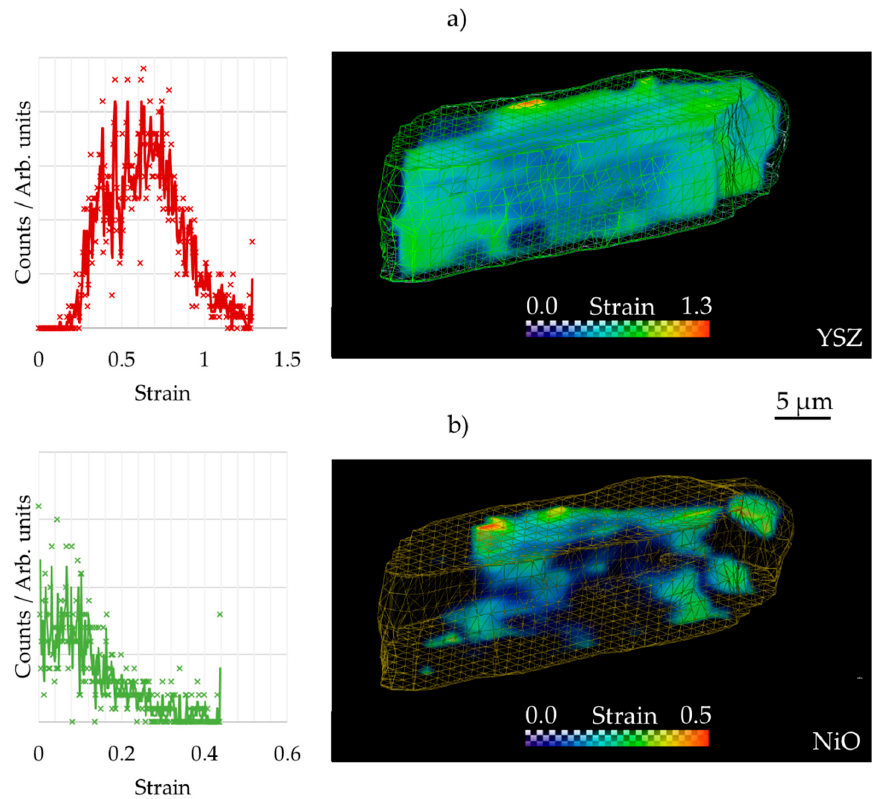
Figure 5. Crystallographic strain mapped in 3D using synchrotron XRD-CT. ( a ) YSZ and ( b ) NiO strain presented as a strain histogram and an accompanying 3D distribution.